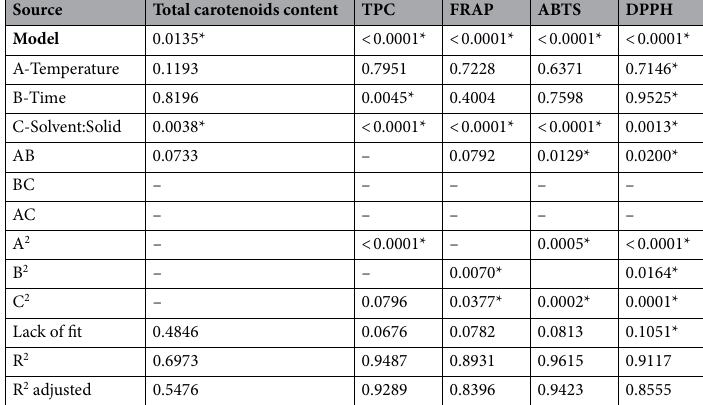
Table 5 represented the regression values for antioxidant activity and the relationship between different extrac- tion parameters and stated that all the parameters represented good correlation coefficient and non-significant lack of fit indicated that the model fits the experimental data adequately. The maximum antioxidant content by FRAP (6735.58 ± 16.37 mM TE/100 g DW) was obtained at a tempera- ture of 40 °C, time 5 min, and solid to solvent ratio of 1:40 (w/v). These results for the antioxidant activity were correlated with the TPC. This can be explained by the fact that carotenoids and phenolic components collectively gave the total antioxidant activity of the substance, FRAP reacts at lower pH of 3.6 for short time, and oxidizes molecules to give antioxidants. Thus in carrot extract, phenolic compounds were reduced to antioxidants more easily than the carotenoids under acidic conditions, which gave total antioxidant activity 28 . The linear effect of solid to solvent ratio and interactive effect of temperature and time significantly affected the total antioxidant activity by FRAP (Table S4(c)). Figure 4a–c represented the interaction of different parameters for total antioxi- dant activity by FRAP. Figure 4a showed the interaction between time and temperature, at a lower temperature, an increase in extraction time led to a gradual increase in antioxidant content measured by FRAP, and at a lower temperature prolonged extraction time gave a higher FRAP value. This observation can be supported by the fact that a higher temperature and short time is more effective for the extraction of antioxidants 47 . Further, a solid to solvent ratio of 1:40 is preferred for the extraction of antioxidants for the entire range of temperature and time. It was observed that a higher solid to solvent ratio enhanced the extraction of compo- nents from the solid and increase the dissolution at different temperatures and times (Fig. 4b,c). Hence from the analysis of the regression model, the optimal extraction conditions for maximum yield for FRAP values were microwave temperature of 50 °C, time 5 min, and solid to a solvent ratio (1:40). The maximum antioxidant content by ABTS (1363 ± 3.67 mM TE/100 g DW) was obtained at a temperature of 50 °C, time of 10 min, and solid to solvent ratio of 1:46.8 (w/v) while the lowest yield (344.67 ± 4.53 mM TE/100 g DW) at 50 °C temperature, time 10 min, and solid to solvent ratio of 1:13.2 (w/v). The results for ABTS were correlated with the total carotenoid content. This can be explained by the fact that ABTS determination is based on the SET mechanism that works at pH around 7.4 that oxidizes the molecules to yield antioxidants. ABTS assay also measured the complex and individual components in the mixture and gave total antioxidant content 39 . Figure 4d–f showed the interaction of time, temperature, and solid to solvent ratio on ABTS value. In general, the interaction results for ABTS were similar to that of FRAP. At fixed conditions of temperature and time, an increase in solid to solvent ratio (1:40) gave the maximum ABTS value (Fig. 4e,f). Further interaction of time and temperature significantly affected the ABTS value (Table S4(d)). A lower range of temperature with a lower extraction time was more effective in the extraction of antioxidants from carrot rejects 48 . Hence the extraction conditions of microwave temperature of 40 °C, time of 5 min, and solid to solvent ratio (1:40) were the optimized results for the maximum ABTS value. The maximum antioxidant content by DPPH (1035.5 ± 3.65 mM TE/100 g DW) was obtained at a tempera- ture of 50 °C, time of 10 min, and solid to solvent ratio of 1:46.8 (w/v). ANOVA results of DPPH proved that temperature, time, and solid to solvent ratio all significantly affected the antioxidant content of DPPH (Table S3). The interaction effect of temperature and time also affected the DPPH value (Table S4(e)). Further, DPPH gave less antioxidant content as compared to other assays due to the insoluble nature of the non-polar components in DPPH solution. Moreover, the interaction factor among different factors defined the same relation as in FRAP and ABTS (Fig. 4 (g-i)). Low extraction temperature with low extraction time resulted in higher neutralization of the DPPH radicals into the solvent and enhanced the antioxidant activity measured by the DPPH assay 49 .